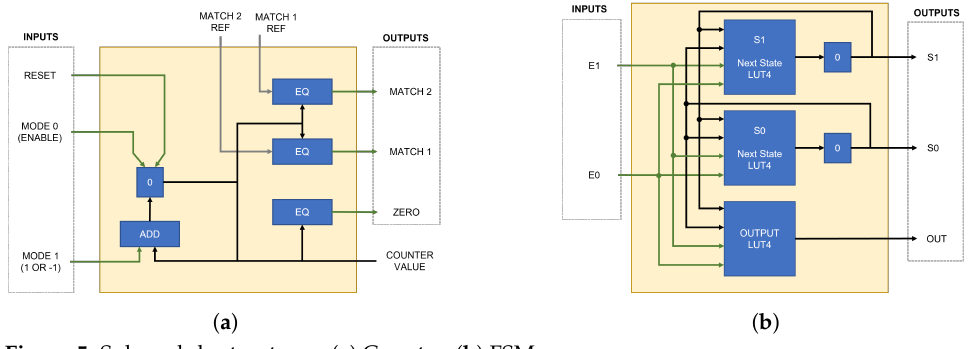
Figure 5. Submodule structures. ( a ) Counter. ( b )